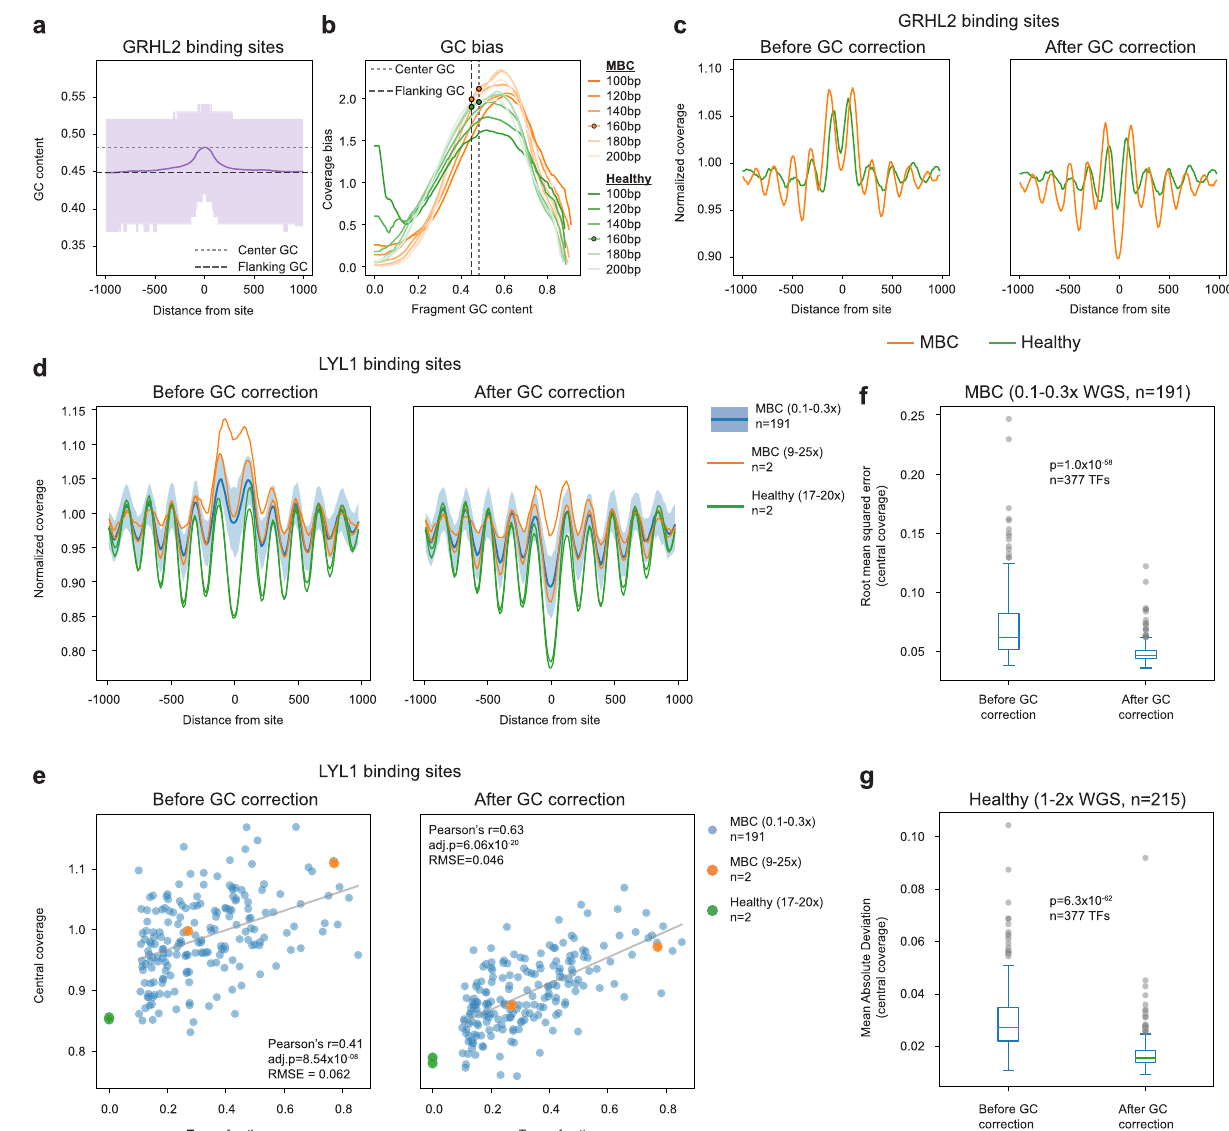
Fig. 2 | Grif fi n GC bias correction improves detection of tissue speci fi c acces- sibilityfromcfDNA.a Mean±IQRofGCcontentaround10,000GRHL2sites. b GC biasofvariousfragmentsizesforcfDNAfromahealthydonor(HD_46;green)anda metastatic breast cancer (MBC_315; orange) sample. GRHL2 center and fl anking GC content are noted with dashed lines (same as [a]). The MBC sample (orange dots) hasalargerdifferencebetweencenter(2.11)and fl anking(1.99)for165bpfragments thanthehealthysample(1.90center,1.96 fl anking;greendots).Thismeansthat,for GRHL2, GC bias will cause increased central coverage relative to the fl anking cov- erage and this effect will be more pronounced in the MBC sample. c Composite coverage pro fi le of 10,000 GRHL2 sites before and after GC correction, shown for HD_46 and MBC_315. Before GC correction, the center has increased coverage due to GC bias. AfterGC correction, the MBCsample haslower centralcoverage, which is consistent with increased GRHL2 activity in tumor cells. d Composite coverage pro fi les of 10,000 LYL1 sites before and after GC correction, shown for two MBC